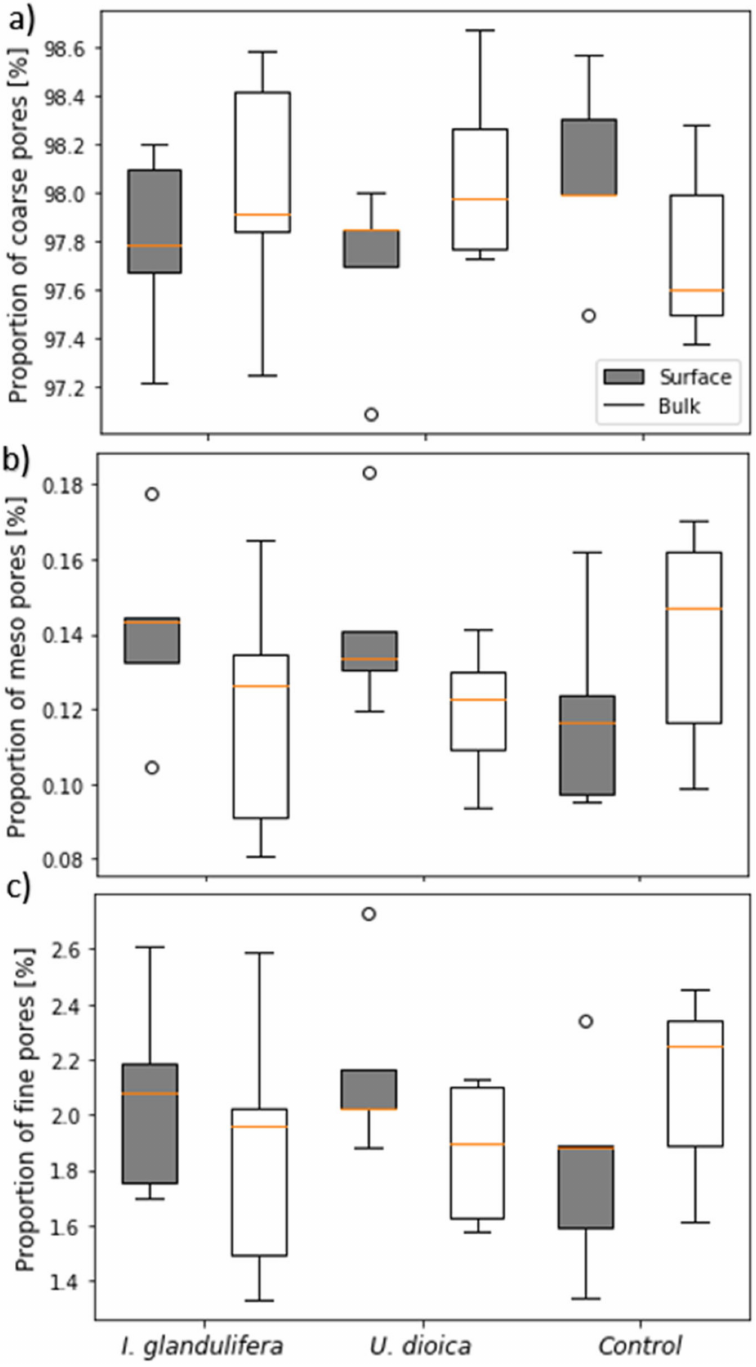
Figure 6. Pore size distribution as proportion of ( a ) coarse pores, ( b ) medium pores, and ( c ) fine pores at the field capacity from surface (0–2 cm) and bulk layers (2–5 cm depth) of soil colonized by Impatiens glandulifera ( I. glandulifera ) and by Urtica dioica ( U. doica ) or of bare soil (Control). The boxes present the lower and upper 25th percentiles with whiskers showing the 1.5 fold interquartiles range (IQR) and all data points outside the 1.5 fold IQR depicted as empty